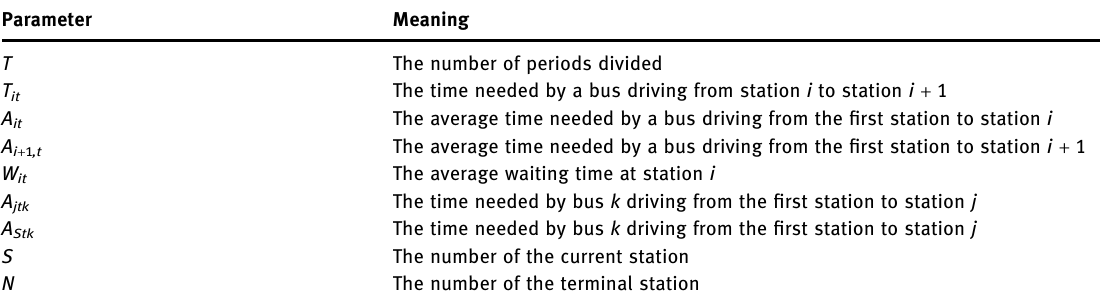
Table 1: Parameters of the historical data - based prediction model